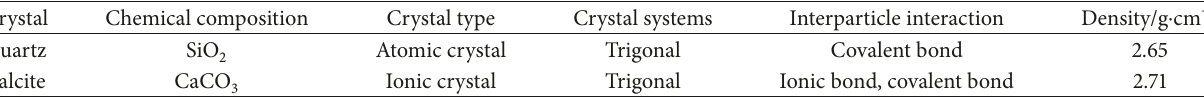
Table 2: Comparison of two different mineral crystals.